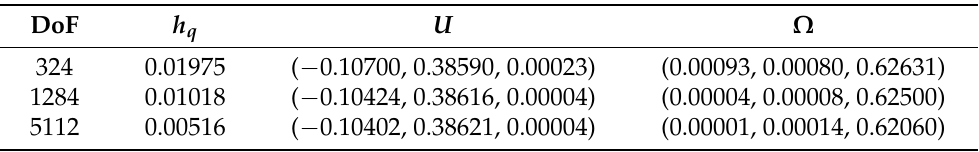
Table A2. Convergence of the numerical solution of the swimming problem for three discretisa- tion levels, for the least slender swimmer with a 0 =